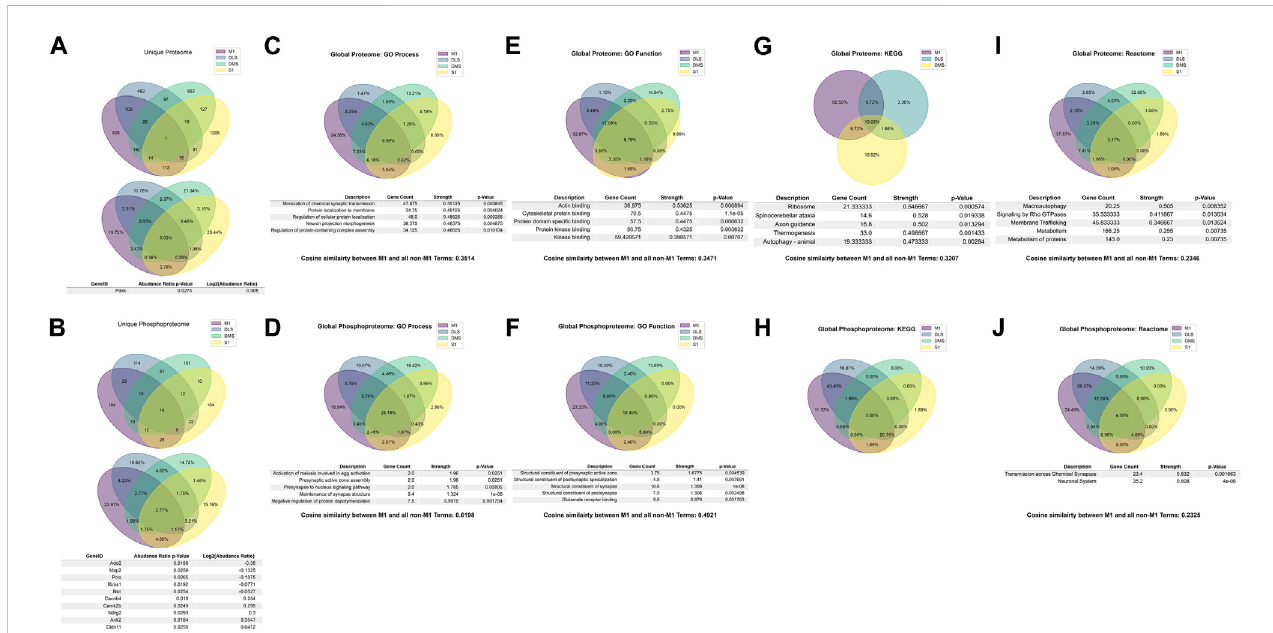
FIGURE 7 Overlap in the protein, phosphopeptides, and gene ontology enrichments between prenatal methadone exposed primary motor cortex (M1), primary somatosensory cortex (S1), dorsolateral striatum (DLS), and dorsomedial striatum (DMS). Across the global proteome (A) , only one associated GeneID was conserved across all brain regions, and across the global phosphoproteome (B) , 19 associated GeneIDs were altered, with the top fi ve strongest positive and negative log2 (abundance ratio) GeneIDs listed. For the GO Process gene ontology enrichments, 9.96% of proteins (C) were similar across all brain regions and M1 to non M1-region terms were assessed using cosine similarity and were 35.14% similar. For the phosphoproteome (D) , 25.18% of terms were similarandtheM1tonon-M1similaritywas61.98%.ForGOFunctionenrichments,8.79%ofproteinterms (E) weresimilarwithaM1tonon-M1similarityscore of34.71%,and18.40%ofphosphopeptideterms (F) weresimilarwithaM1tonon-Mascoreof49.21%.ForKEGGenrichments,therewerenotanysigni fi cantly enriched proteins (G) in the S1 region, so the similarity between protein terms was 10.08% and the M1 to non-M1 similarity score was 32.07%. The KEGG enrichments for the phosphoproteome (H) had no overlapping terms and therefore no M1 to non-M1 similarity score. For the Reactome enrichments for the proteome (I) there were 3.17% similarity between protein terms, and a M1 to non-M1 similarity score of 23.46%. For the phosphoprotein Reactome (J) there was 4.08% overlap and a M1 to non-M1 similarity score of